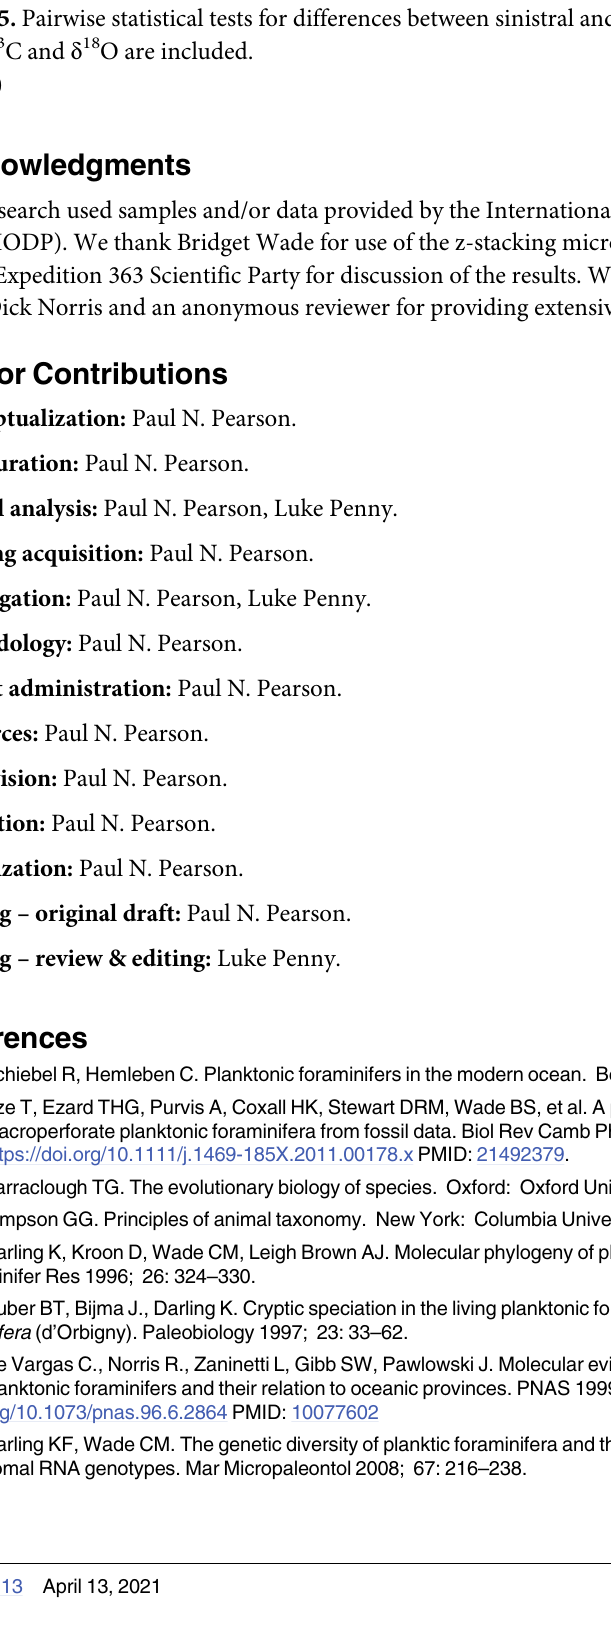
S7 Table. Pulleniatina absolute abundances and flux calculations from Windows W1-W5. S8 Table. Sinistral and dextral Pulleniatina size and stable isotope data from Windows W1-W5. Pairwise statistical tests for differences between sinistral and dextral populations for size, δ 13 C and δ 18 O are